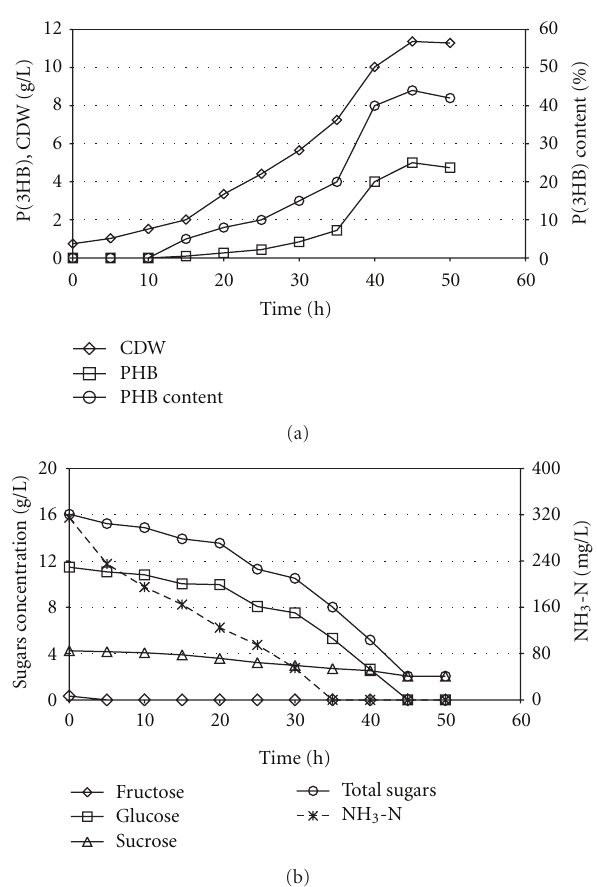
Figure 1: (a) Time profile of cell growth and P(3HB) production by C. necator (CCUG52238 T ) using OPF juice in 2-L bioreactor at 30% DOT level. (b)Time profile of sugars and ammonical nitrogen utilization by C. necator (CCUG52238 T ) using OPF juice in 2-L bioreactor at 30% DOT